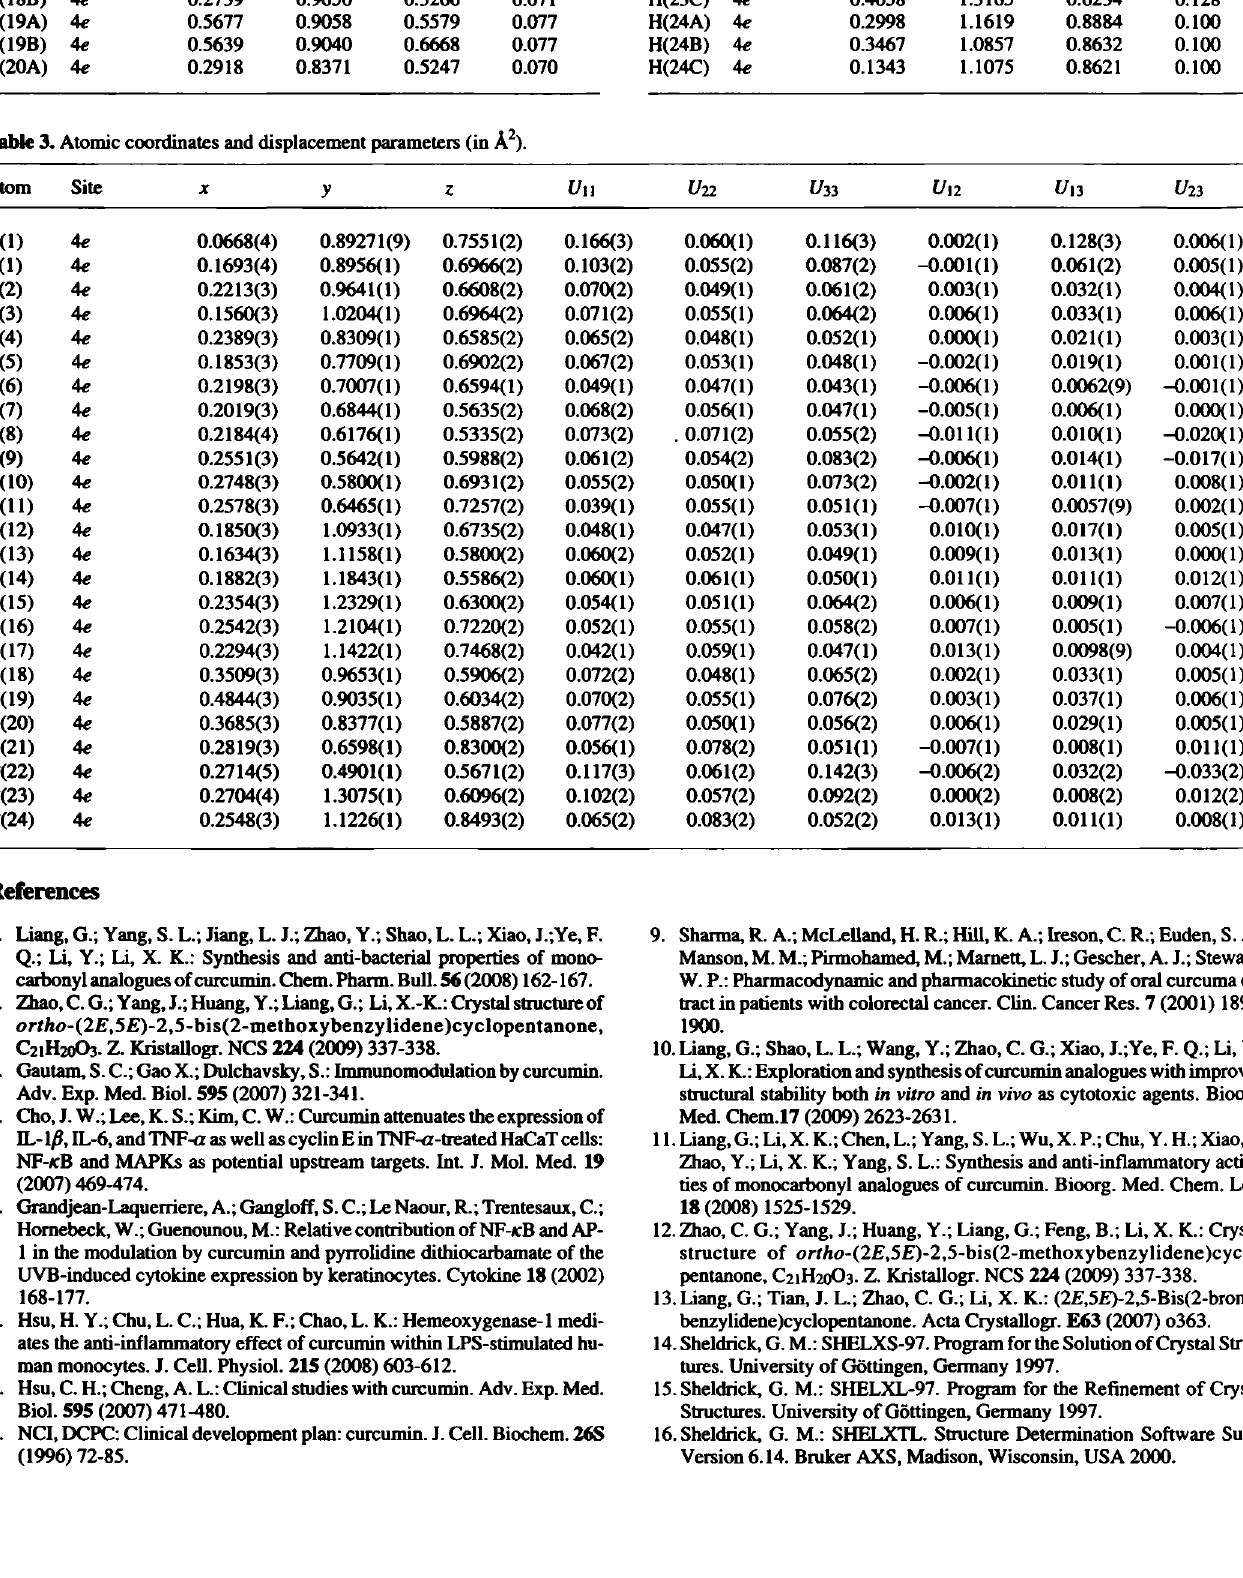
Table 3. Atomic coordinates and displacement parameters (in À 2